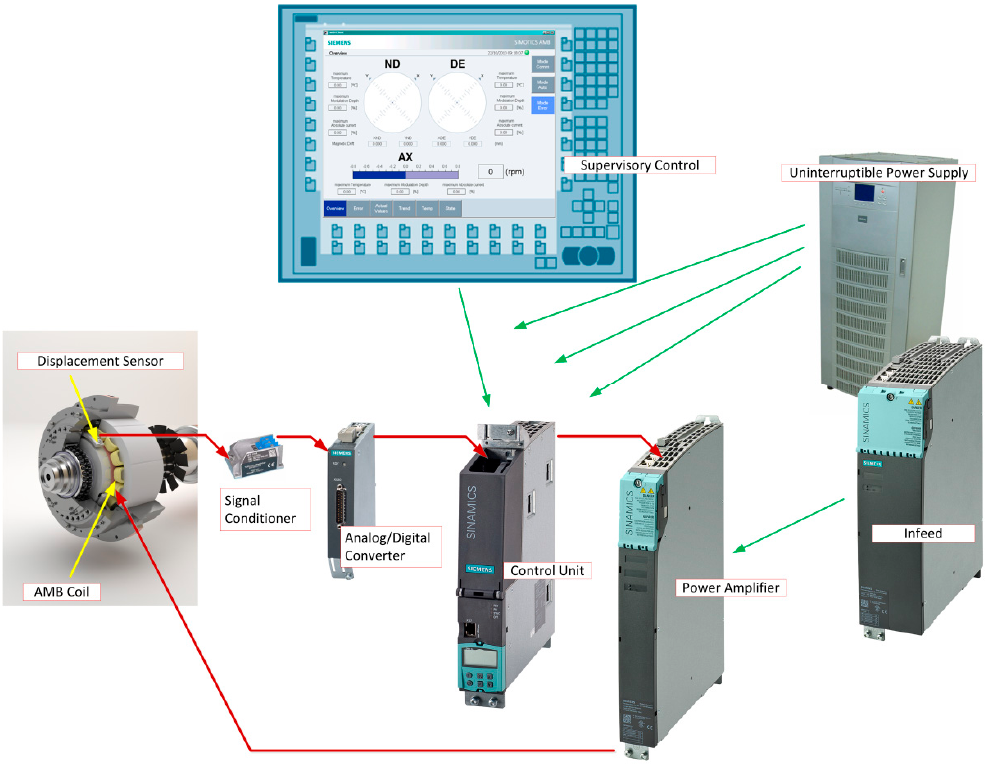
Figure 2. Electronics and power electronics of a magnetic bearing. The major components are: displacement sensors, signal conditioners, analog/digital converters, control units, supervisory control system, power amplifiers, and an infeed. The infeed provides the DC link for the power amplifiers. Furthermore, a standard 400 V industrial uninterruptible power supply (UPS) is used to ensure uninterrupted operation in case of short term power failures.